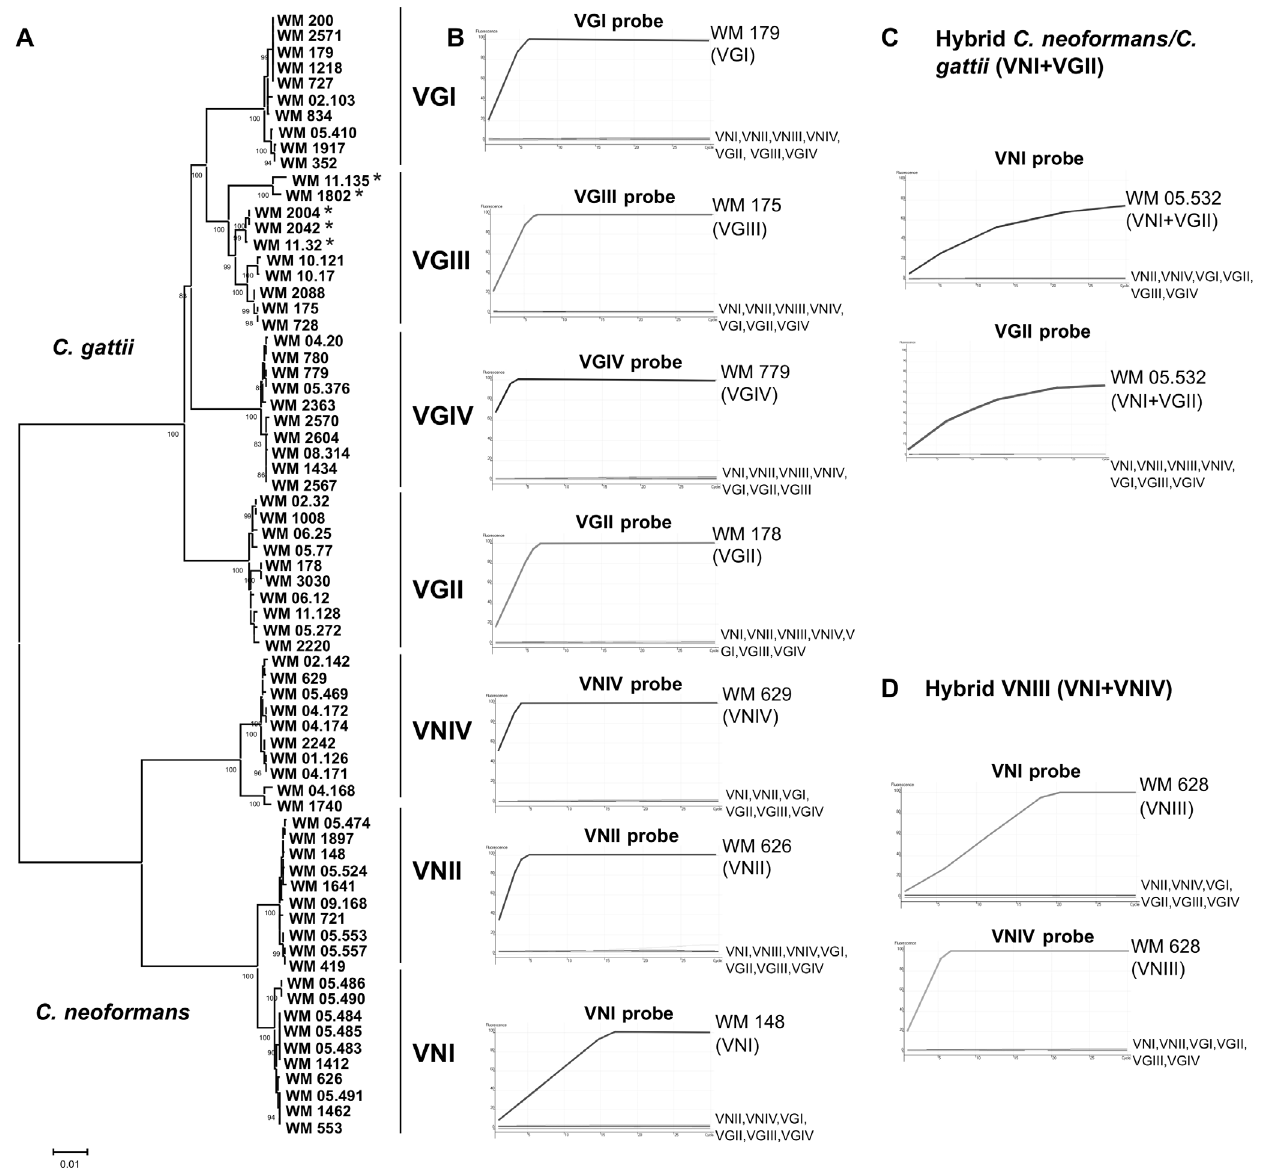
Figure 1. Association between MLST clusters and HRCA curves. ( A ) Unrooted neighbor-joining tree inferred from the combined sequences of CAP59 , GPD1 , LAC1 , SOD1 , URA5 , PLB1 genes and IGS of 76 strains tested in this study. Numbers on branches are bootstrap support values obtained from 1,000 pseudoreplicates. *VGIII only when determined by the ISHAM MLST scheme, URA5 RFLP is grouping them incorrectly to VGIV due to a point mutation in the RFLP restriction site; ( B ) Amplification curves for representative strains of each major haploid molecular type, C. neoformans molecular types VNI, VNII and VNIV and C. gattii molecular types VGI, VGII, VGIII and VGIV obtained with the respective HRCA probes. ( C ) C. neoformans/ C. gattii VNI + VGII hybrid strain (WM 05.532), positive amplification with the HRCA probes VNI-PLB and VGII-PLB. ( D ) C. neoformans VNIII hybrid strain (WM 628), positive amplification with the HRCA probes VNI-PLB and VNIV-PLB. Positive results are indicated when the fluorescence signals increased